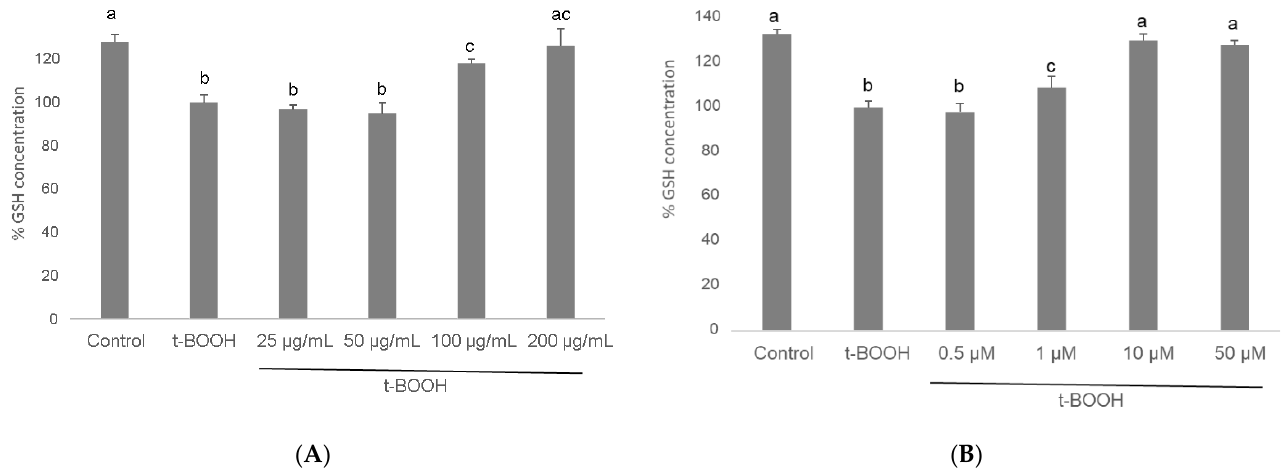
Figure 5. Effect of pre-treatment of differentiated SH-SY5Y cells with cocoa extract ( A ) and EC ( B ) prior to oxidative stress on ROS generation determined by flow cytometry. Values are means ± SD, n = 8. Values are expressed as a percent relative to the control condition. Different letters indicate statistically significant differences ( p < 0.05) among groups.